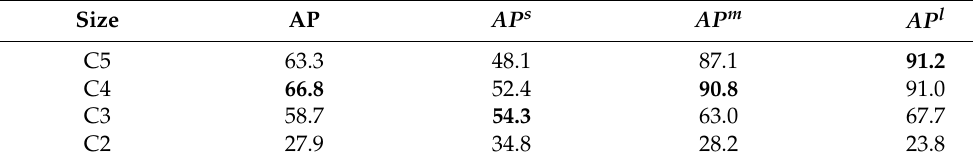
Table 2. The influence of convolution feature depth changes on ship detection accuracy.